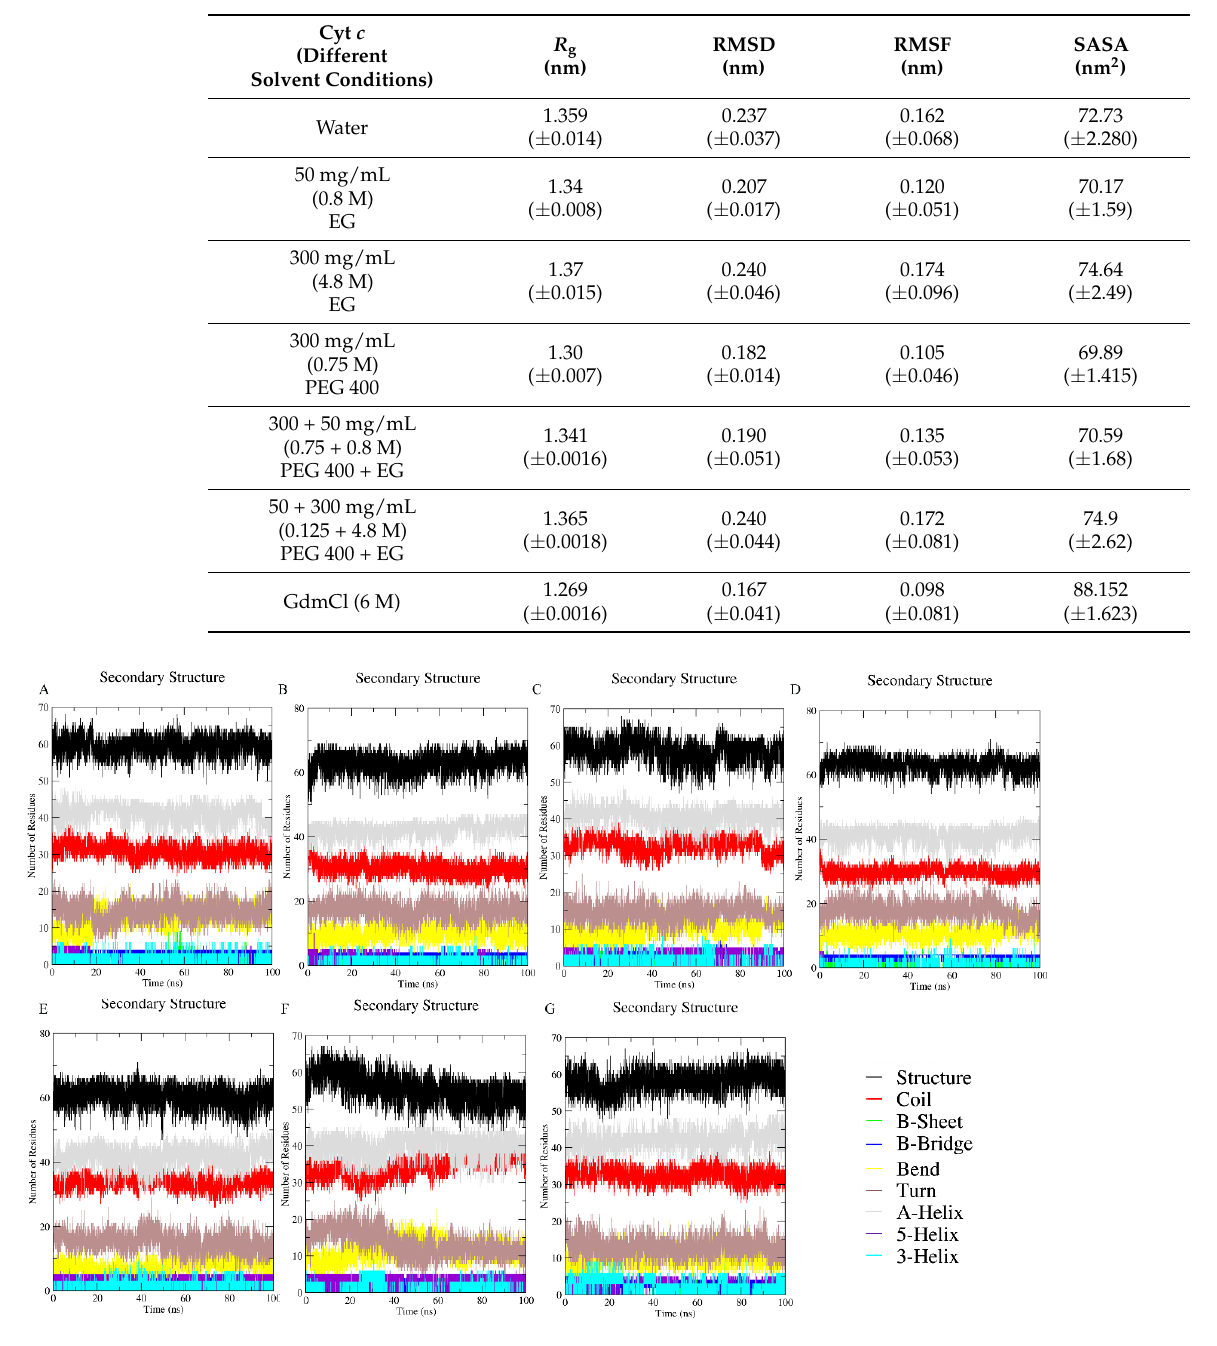
Figure 4. Fluctuations in the structure elements of cyt c in ( A ) water, ( B ) 50 mg/mL (0.8M) of EG, ( C ) 300 mg/mL (4.8 M) of EG, ( D ) 300 mg/mL (0.75 M) of PEG 400, ( E ) 300 mg/mL of PEG 400 (0.75 M) + 50 mg/mL of EG (0.8 M), ( F ) 50 mg/mLof PEG 400 (0.125 M) + 300 mg/mL of EG (4.8 M), and ( G ) GdmCl (6M) solutions.